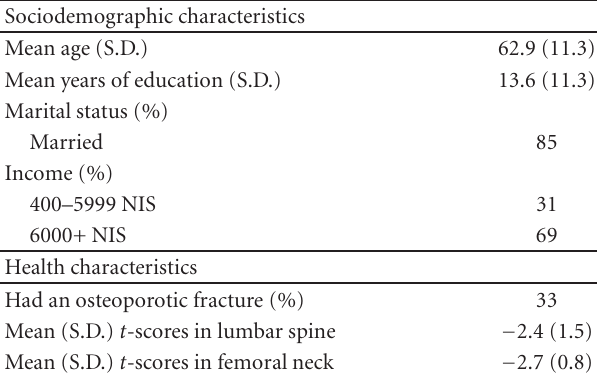
Table 1: Sociodemographic and health characteristics ( n = 100). Sociodemographic characteristics Mean age